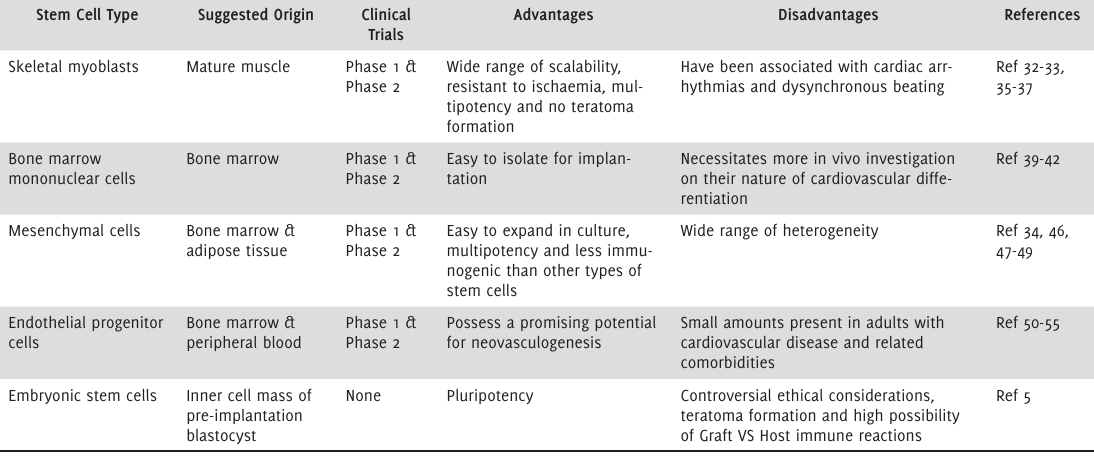
Table 2. Summary of Exogenous Stem Cell